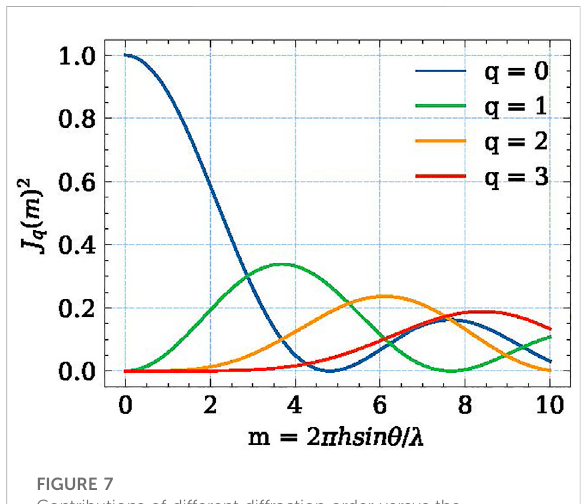
FIGURE 7 Contributions of different diffraction order versus the magnitudeofthesurfaceshapeerrorunderthecosineshapeerror